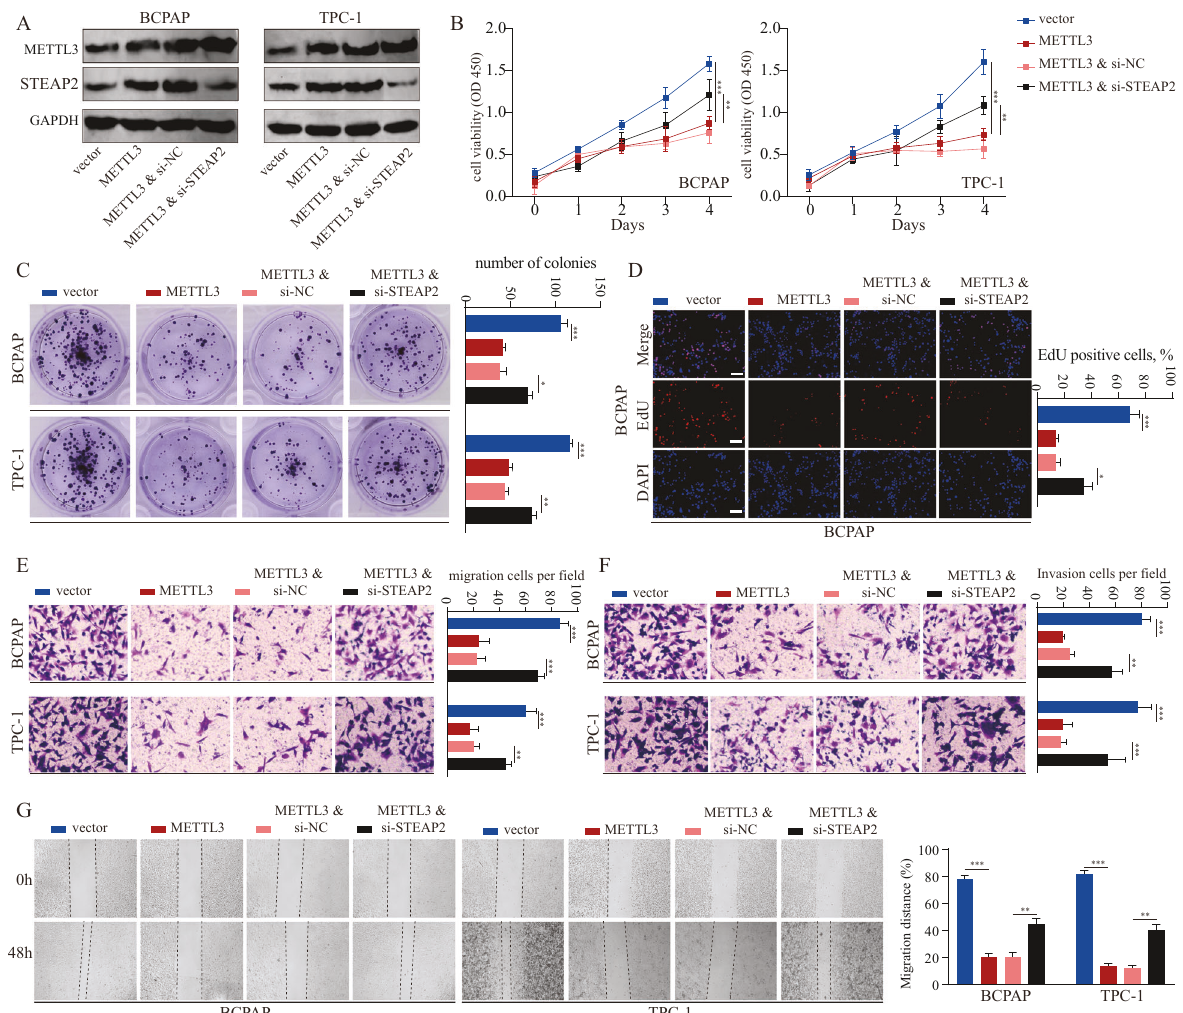
Fig. 7 METTL3 accelerates PTC malignant progression by upregulating STEAP2. A BCPAP and TPC-1 cell lines were transfected with METTL3-overexpression (METTL3) plasmids and siRNA targeting STEAP2 (si-STEAP2) as indicated. The expression levels of METTL3 and STEAP2 were quanti fi ed by western blot assay. The effects of METTL3 and STEAP2 on proliferative ability of PTC cells were measured by CCK-8 assay ( B ), colony formation assay ( C ), and EdU assay ( D ). The effects of METTL3 and STEAP2 on invasive ability of PTC cells were determined by transwell migration assay ( E ), transwell invasion assay ( F ), and wound healing assay ( G ). All data are presented as the mean ± standard deviation of three independent experiments. * P < 0.05, ** P < 0.01, and *** P < Analysis of public databases The raw expression data for PTC samples were gained from the Cancer Genome Atlas (TCGA) and GEO database. The individual datasets (GSE3467, GSE33630, GSE35570, GSE60542) were analyzed in this study. Immunohistochemistry analysis The slides were subjected to 30 min of H 2 O 2 solution (0.3%) treatment to inhibit the activity of endogenous peroxidase. Permeabilization was conducted by treating tissues with 0.5% Triton X-100 for 30 min, followed by incubation of tissues with citrate buffer at working strength to identify the relevant antigen. Following three times of rinsing with PBS, 5% normal goat serum was used to block the slides. Samples were subsequently subjected to cross-reaction with STEAP1 antibody (Proteintech: 20199-1- AP, China), STEAP2 (Proteintech: 20201-1-AP, China), STEAP3 (Proteintech: